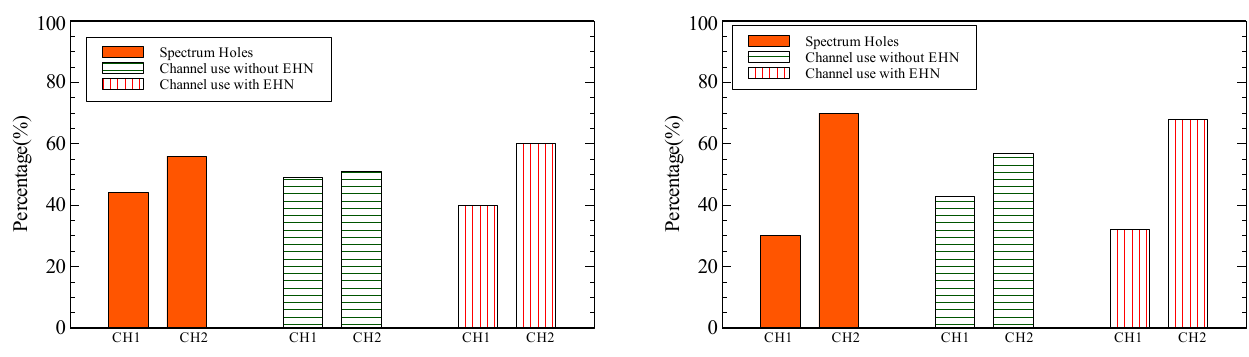
Channel handovers Throughput (Mbps)